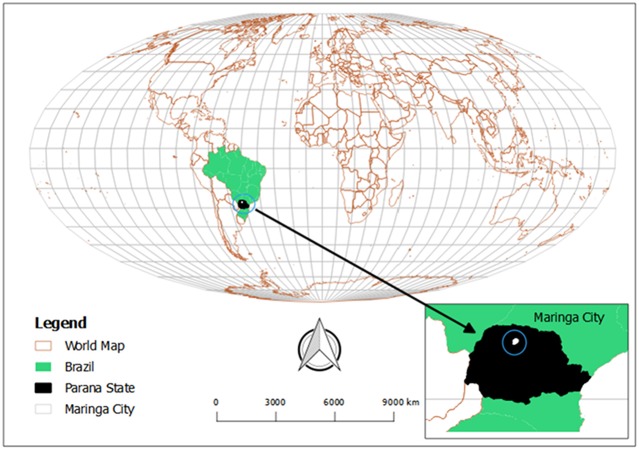
Location of study setting created from OpenStreetMap.org.